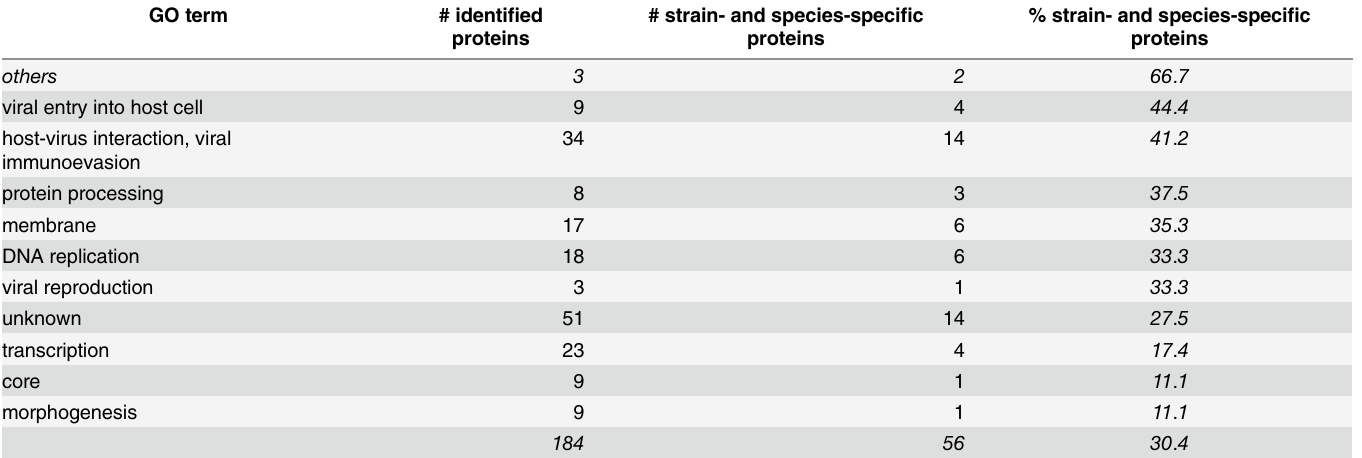
Table 2. GO term distribution of strain- and species-specific OPV